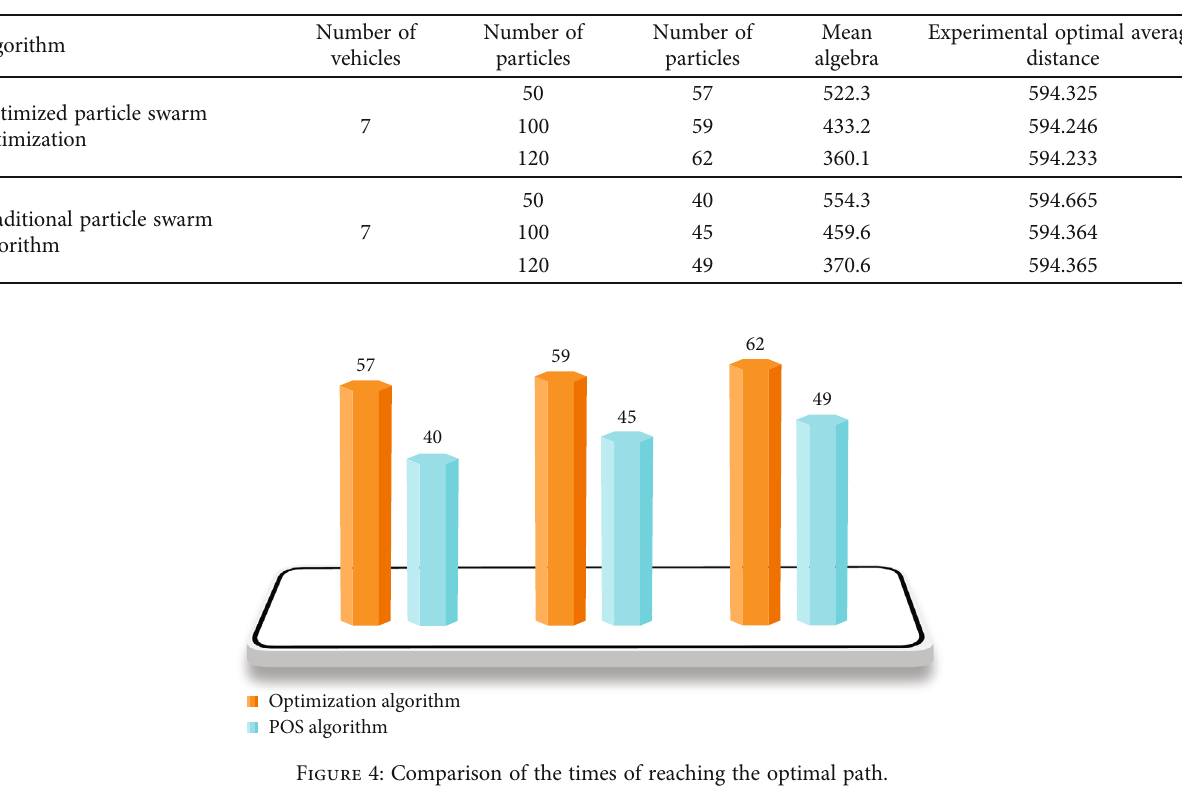
Table 1: Simulation results.